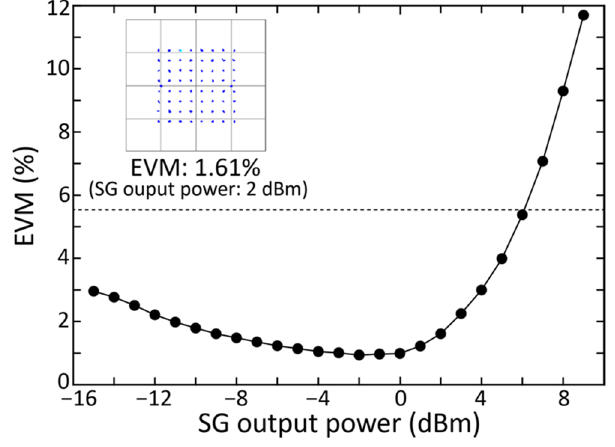
Figure 4. EVM as a function of SG output power. Dashed line shows EVM of 5.6%. Inset shows constellation of transmitted RF data signal when SG output power was 2 dBm.